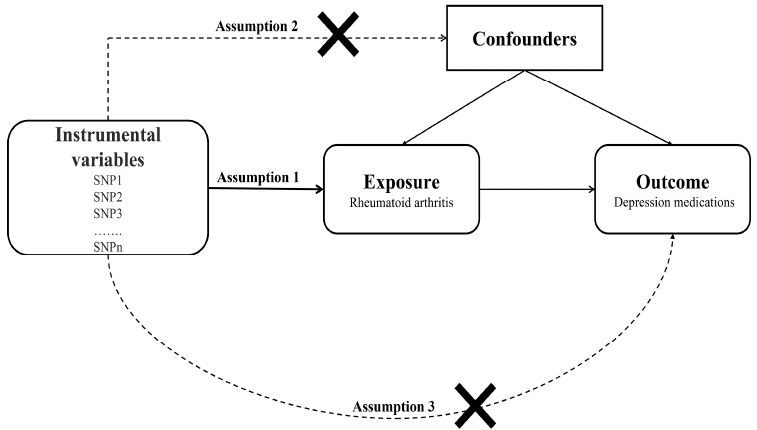
Figure 1. An overview of the study design. SNP, single-nucleotide polymorphism.